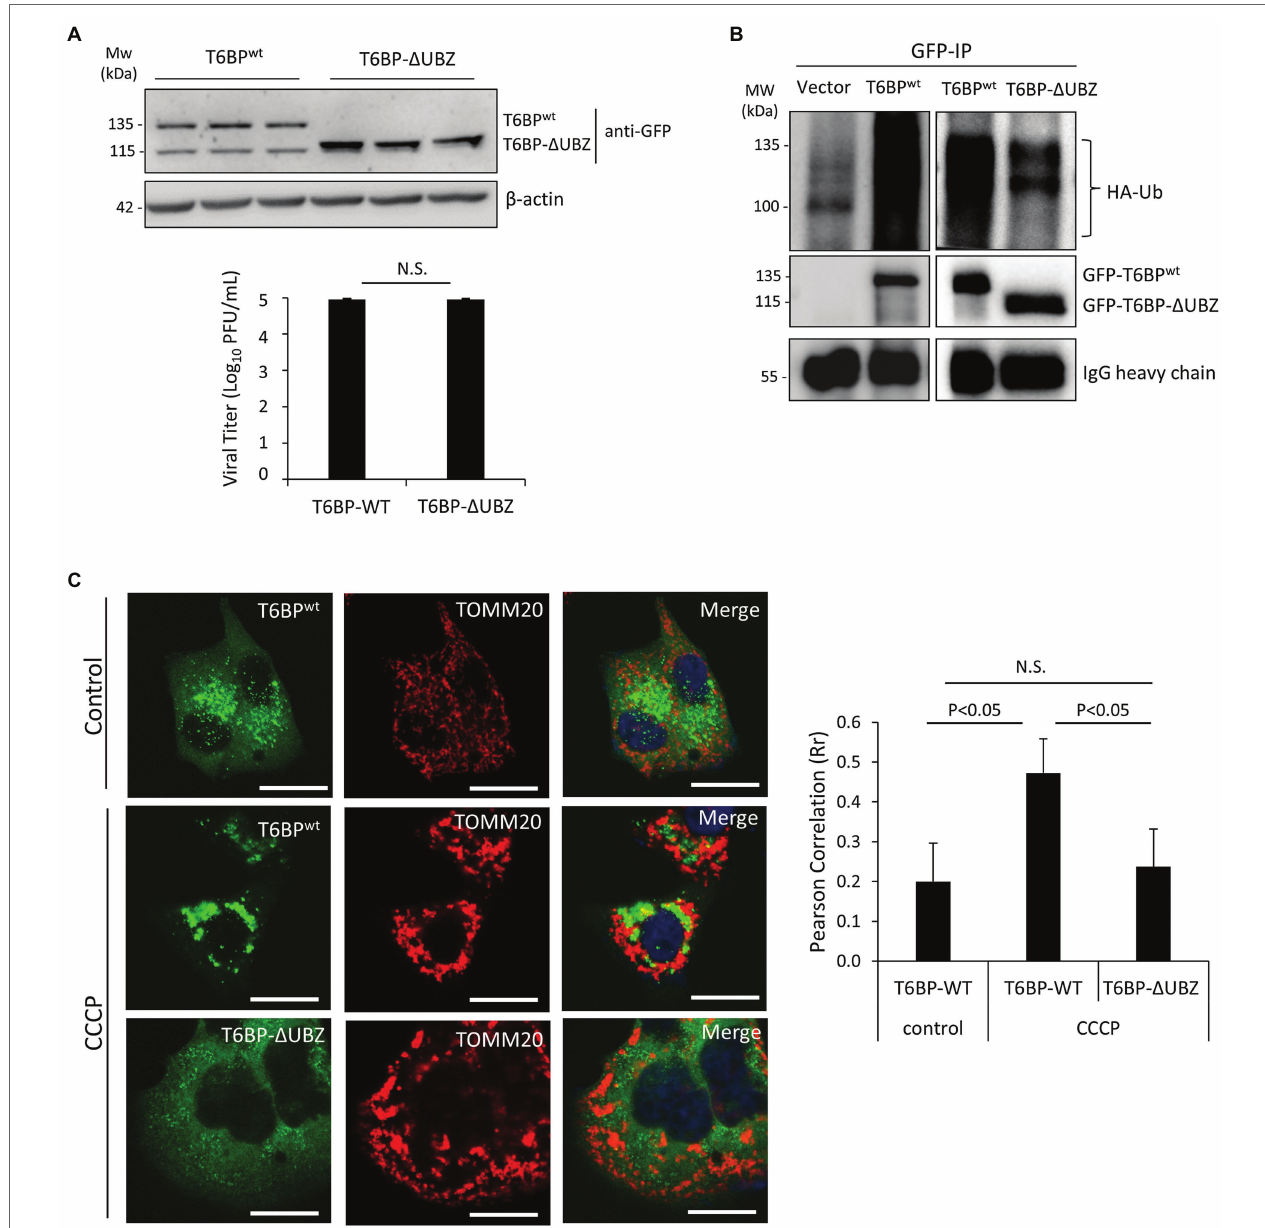
FIGURE 7 | The N-terminal T6BP fragment has the reduced binding affinity with ubiquitin and fails to be effectively recruited to mitochondria. (A) HeLa cells were transiently transfected with GFP-T6BP wt or GFP-T6BP- Δ UBZ for 24 h. Cells were subsequently infected with CVB3 (MOI = 0.1) for 24 h. Lysates were harvested for Western blot analysis with anti-GFP and β -actin antibodies. Supernatants were harvested for quantitation of viral titers and presented in the bar graph (mean ± SD, n = 3). (B) HeLa cells were transfected with HA-ubiquitin, together with either empty vector, GFP-T6BP wt , or GFP-T6BP- Δ UBZ for 24 h. Cell lysates were subjected to immunoprecipitation with anti-GFP antibody, followed by Western blot analysis of the interaction between WT-T6BP or T6BP- Δ UBZ and ubiquitin using anti-HA and anti-GFP antibodies. (C) HeLa cells were transfected with either GFP-T6BP wt or GFP-T6BP- Δ UBZ for 24 h. Cells were then treated with either vehicle or CCCP (10 μ m) for 6 h. Co-localization of T6BP and mitochondrial marker TOMM20 was assessed using NIH ImageJ software and presented as Pearson’s correlation (Rr ± SD, n > 30 cells) in the right panel. Scale bar = 20 μ